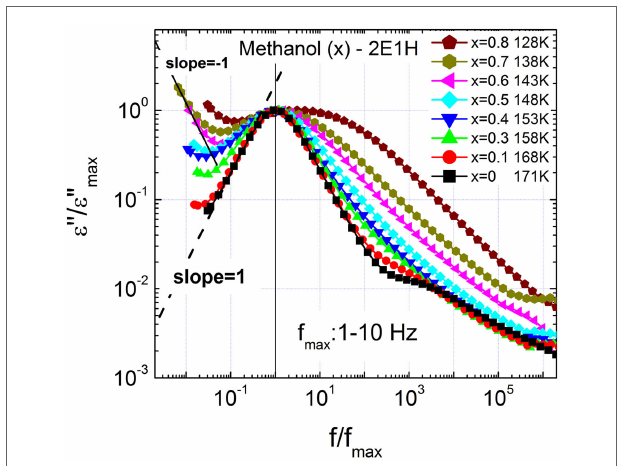
FigUre 4 | relaxation dispersion parameters, α hn and γ hn in havriliak–negami equation for relaxations i and ii . FigUre 2 | normalized dielectric loss spectra of methanol – 2-ethyl-